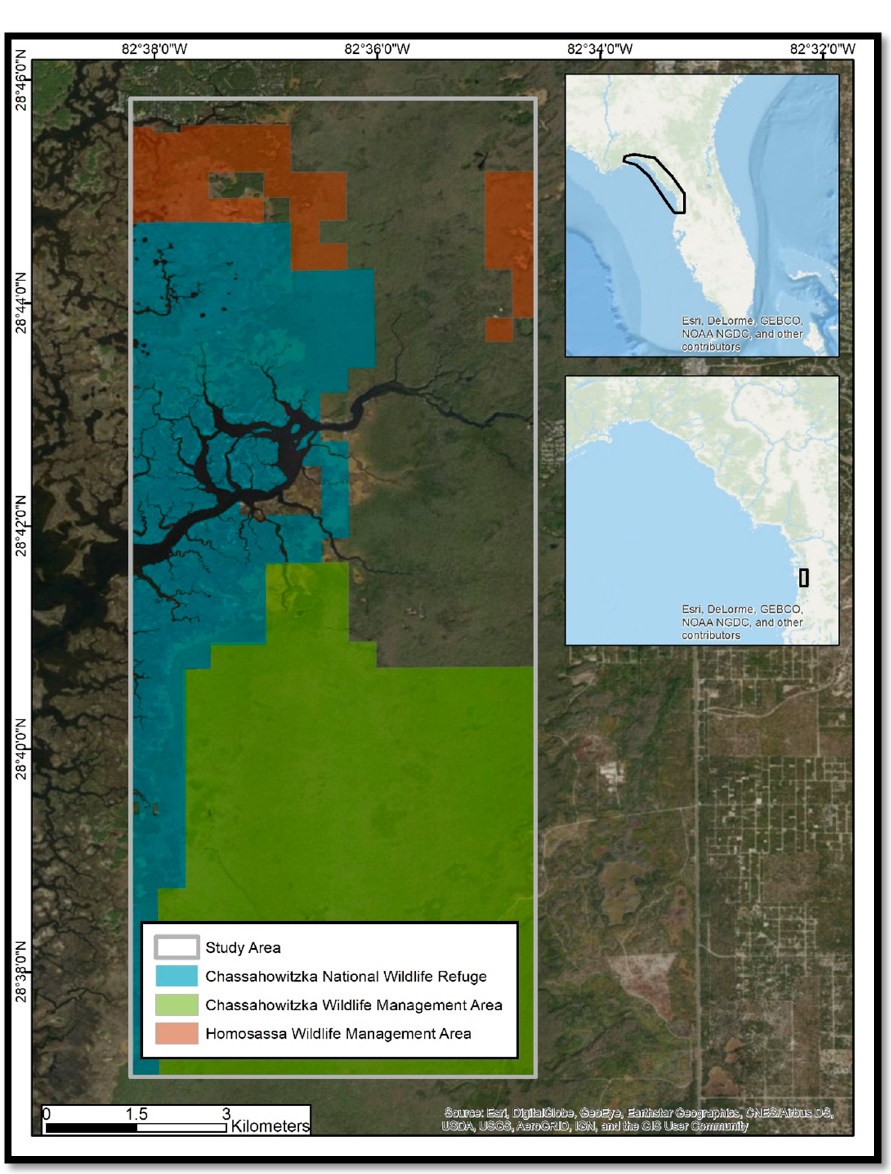
Figure 1. Study area (grey box) showing the three wildlife management and refuge areas within the Big Bend region of Florida’s Gulf coast (inset maps; background map source: ArcGIS ® basemaps).